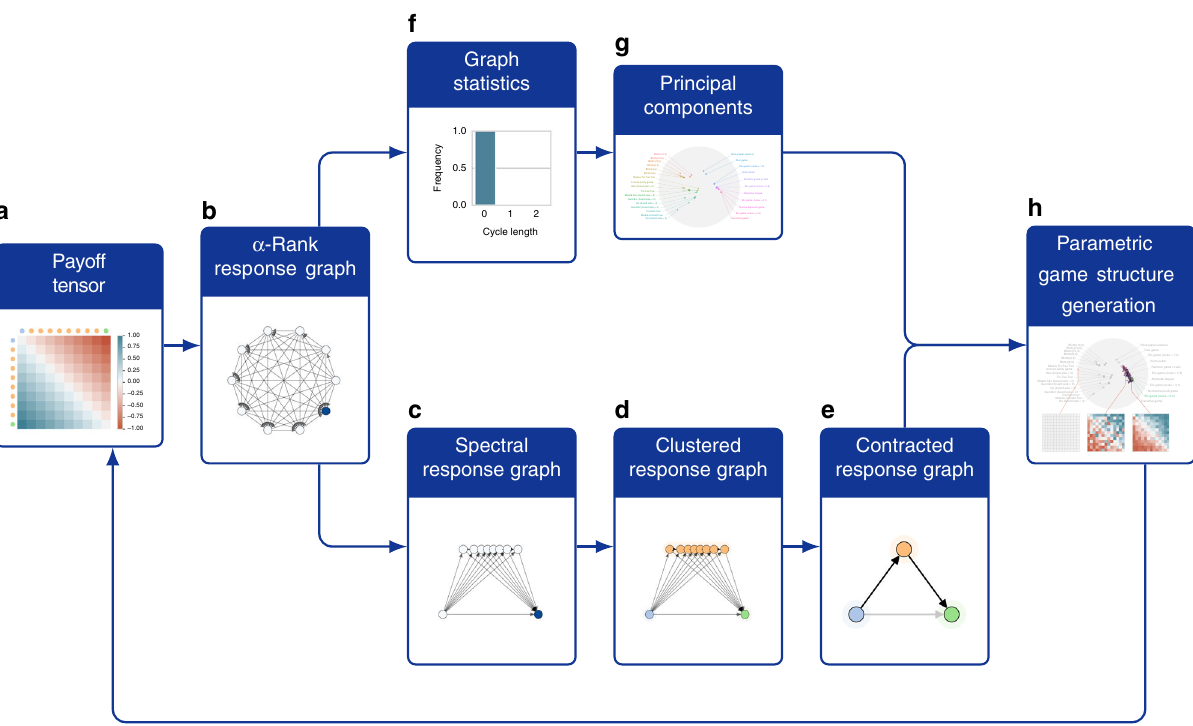
Fig. 3 Method work fl ow, with accompanying transitive game results. Given the game payoffs a , the so-called α -Rank response graph of the game is visualized in b . In c , reprojecting the response graph by using the top eigenvectors of the graph Laplacian yields the spectral response graph, wherein similar strategies are placed close to one another. In d , taking this one step further, one can cluster the spectral response graph, yielding the clustered response graph, which exposes three classes of strategies in this particular example. In e , contracting the clustered graph by fusing nodes within each cluster yields the high-level characterization of transitive games. In f , the lack of cycles in the particular class of transitive games becomes evident. Finally, in g and h , one can extract the principal components of various response graph statistics and establish a feedback loop to a procedural game structure generation scheme to yield new